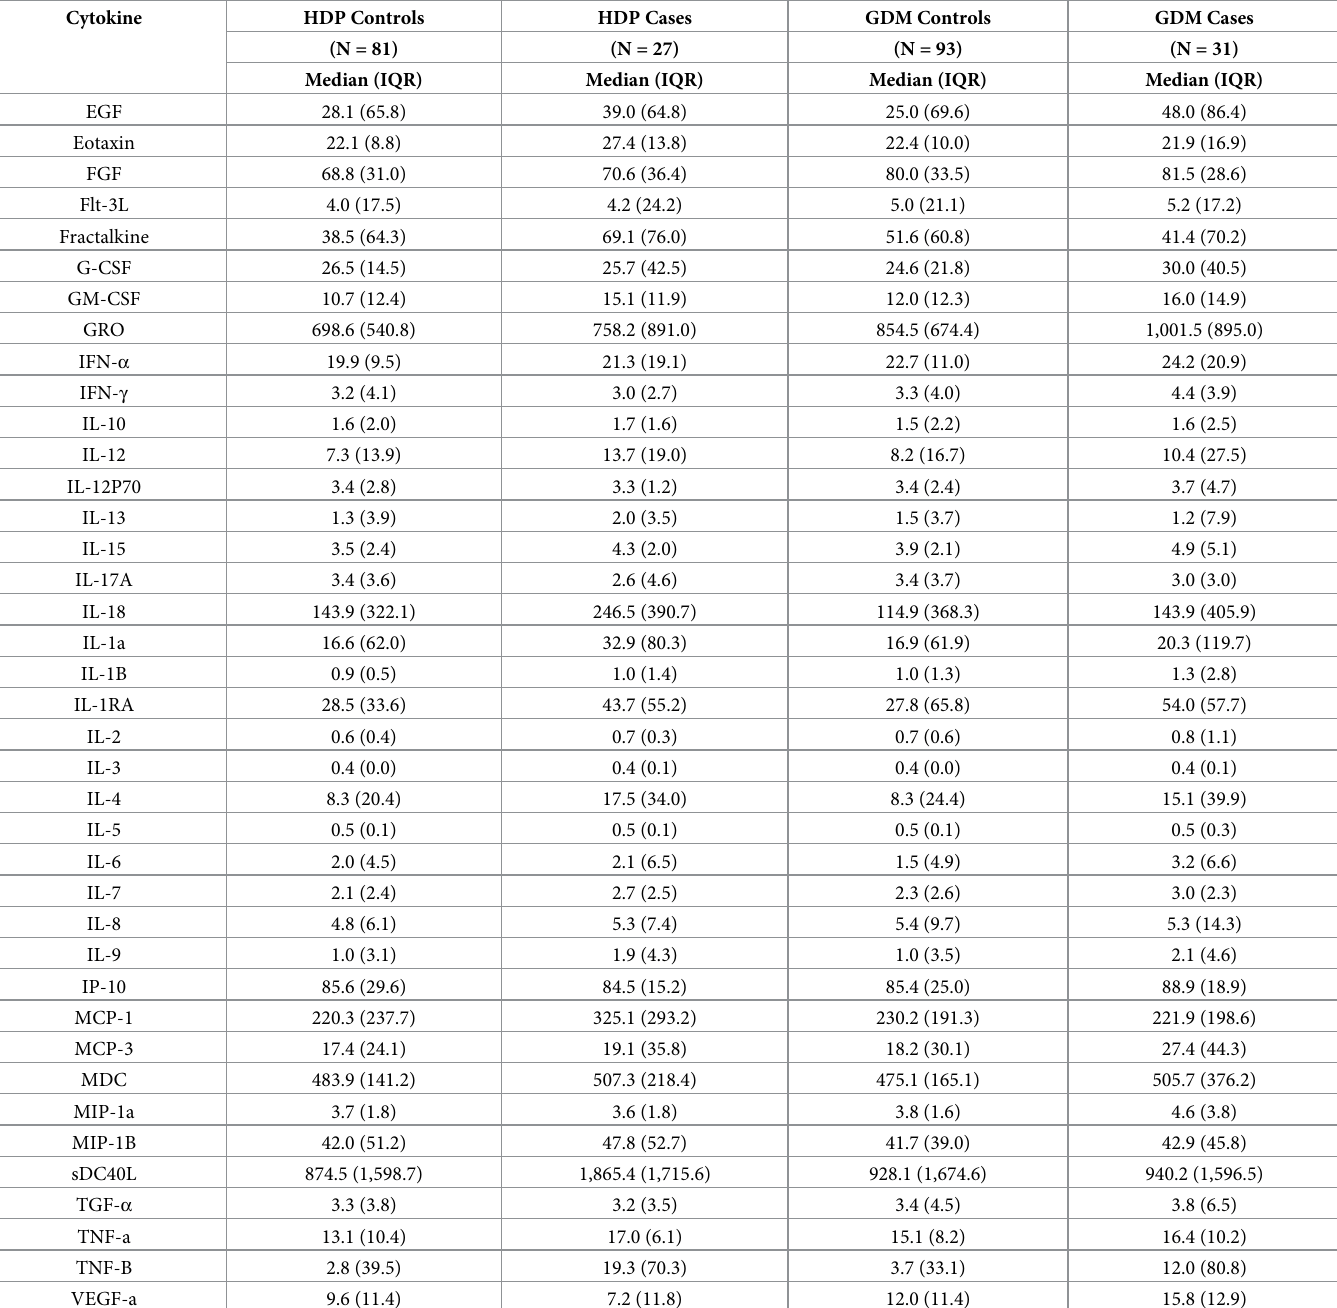
Table 2. Summary of the median and interquartile range (IQR) of cytokine levels (pg/mL) in plasma of those with HDP or GDM and those without